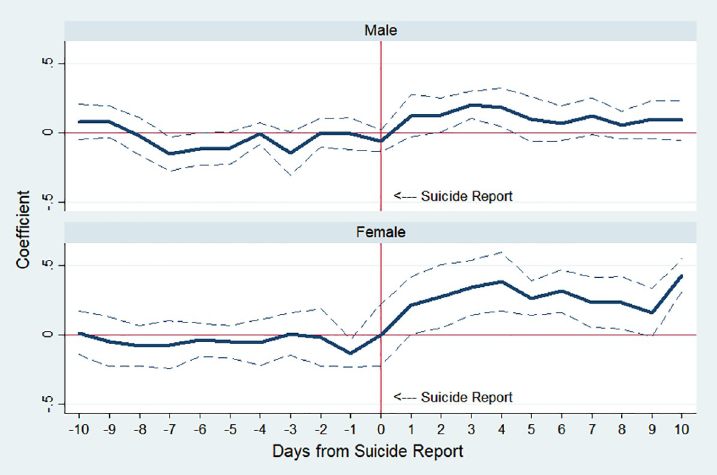
Fig 4. Estimated changes in total suicides by gender before and after media reports on celebrity suicide. Note: The y -axis indicates an approximate percent change in public suicide by corresponding day, which is the estimated β k in Eq (1). The dotted lines indicate 95% confidence interval.